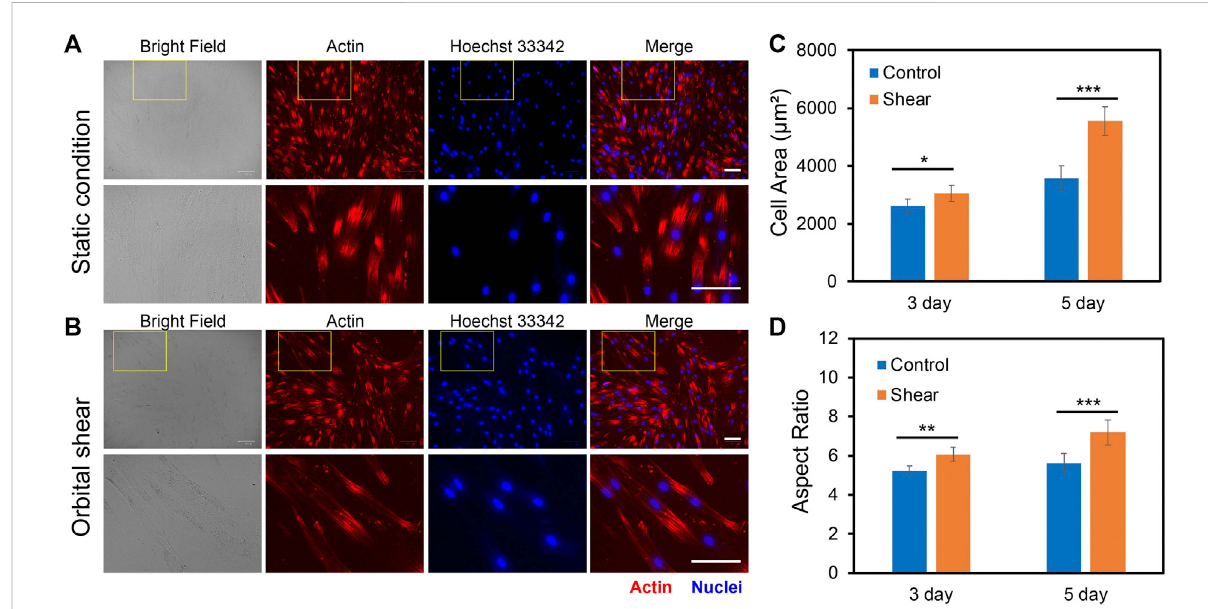
FIGURE 3 Effects of orbital shear stress on hMSCs morphology change. Representative bright fi eld and fl uorescence images of hMSCs under static condition (A) and exposed to shear stress (B) . The bottom panel showed the enlarged area of a yellow rectangle in the upper panel. hMSCs were exposed to orbital shear for 6 h per day for 5 days. Samples were stained with F-actin (red; by phalloidin), and nuclei (blue; by hoechst 33342), respectively. Scale bar: 100 μ m. Quanti fi cation of observed cell area (C) and cell aspect ratio (D) of hMSCs after 3 and 5 days of exposure to orbital shear with 6 h per day. Data represent over 100 cells in each group and are expressed as mean± s.e.m. ( n = 5, ***, p < 0.001, **, p < 0.01, *, p <